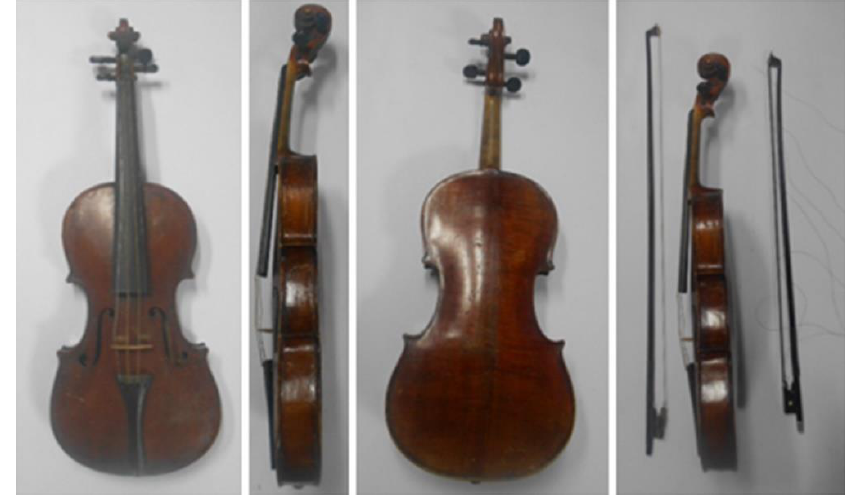
Figure 3. The images of the violin.